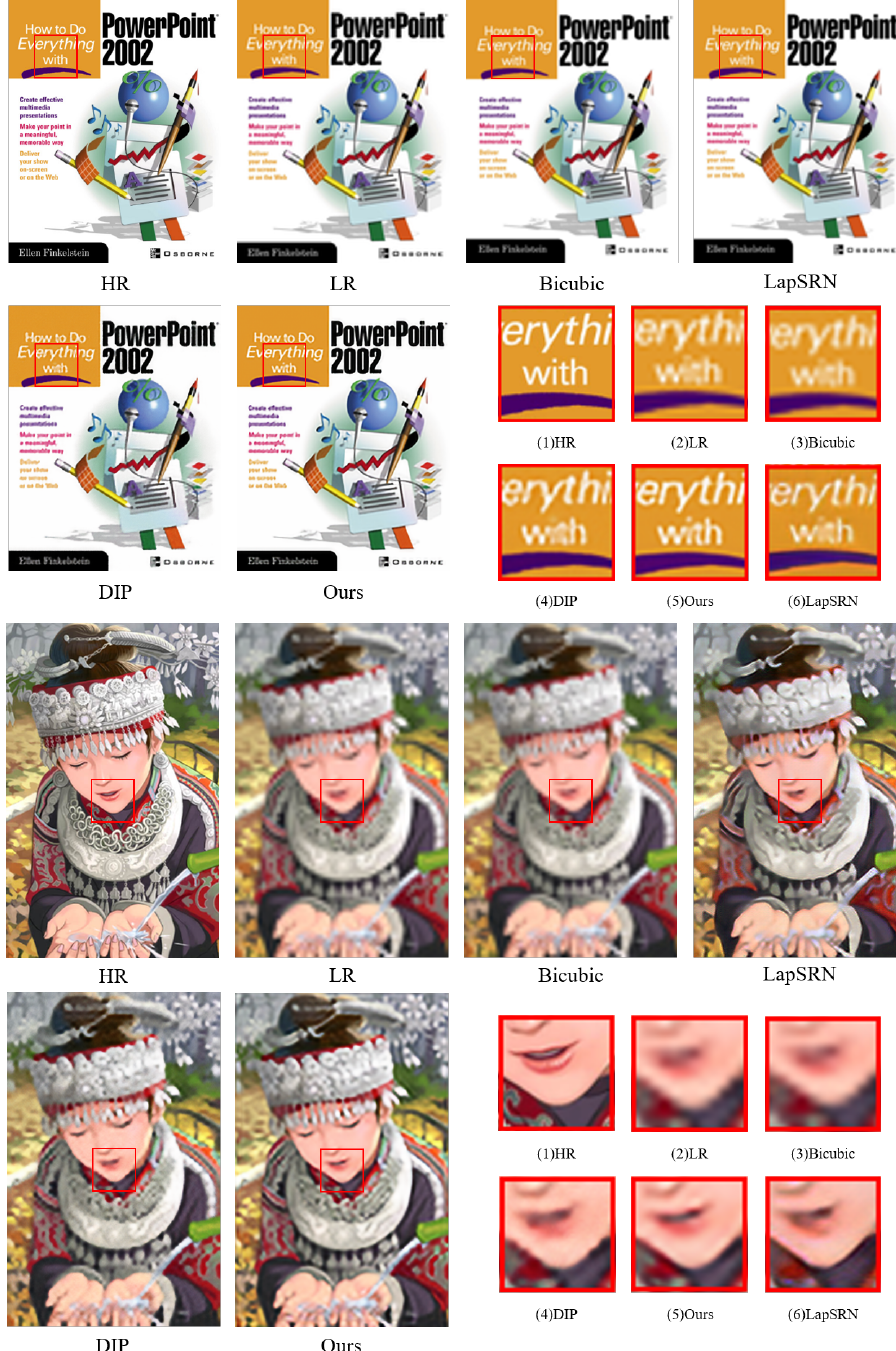
Figure 7. The visualization of 4 × super resolution